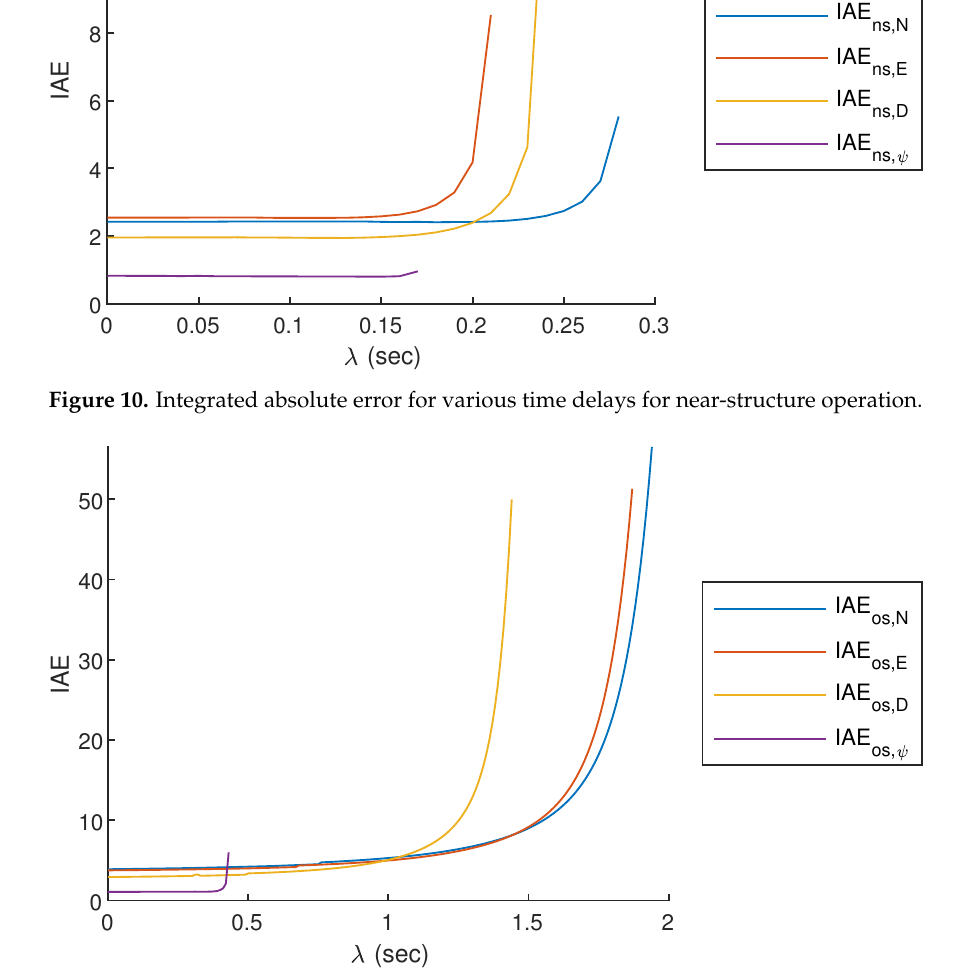
Figure 11. Integrated absolute error for various time delays for off-structure